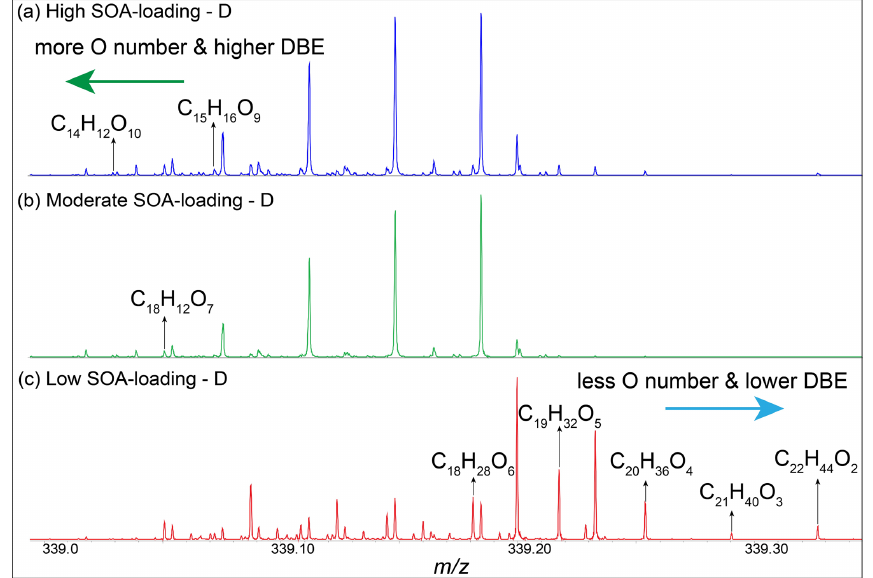
Figure 6. Mass-scale-expanded segments (0.30Da) of the broadband mass spectra for CHO compounds. The shift to higher mass defect in the low SOA-loading group – D sample reflects lower oxygen content and DBE value, and vice versa reflects higher oxygen content and DBE value in high and moderate SOA-loading groups – D